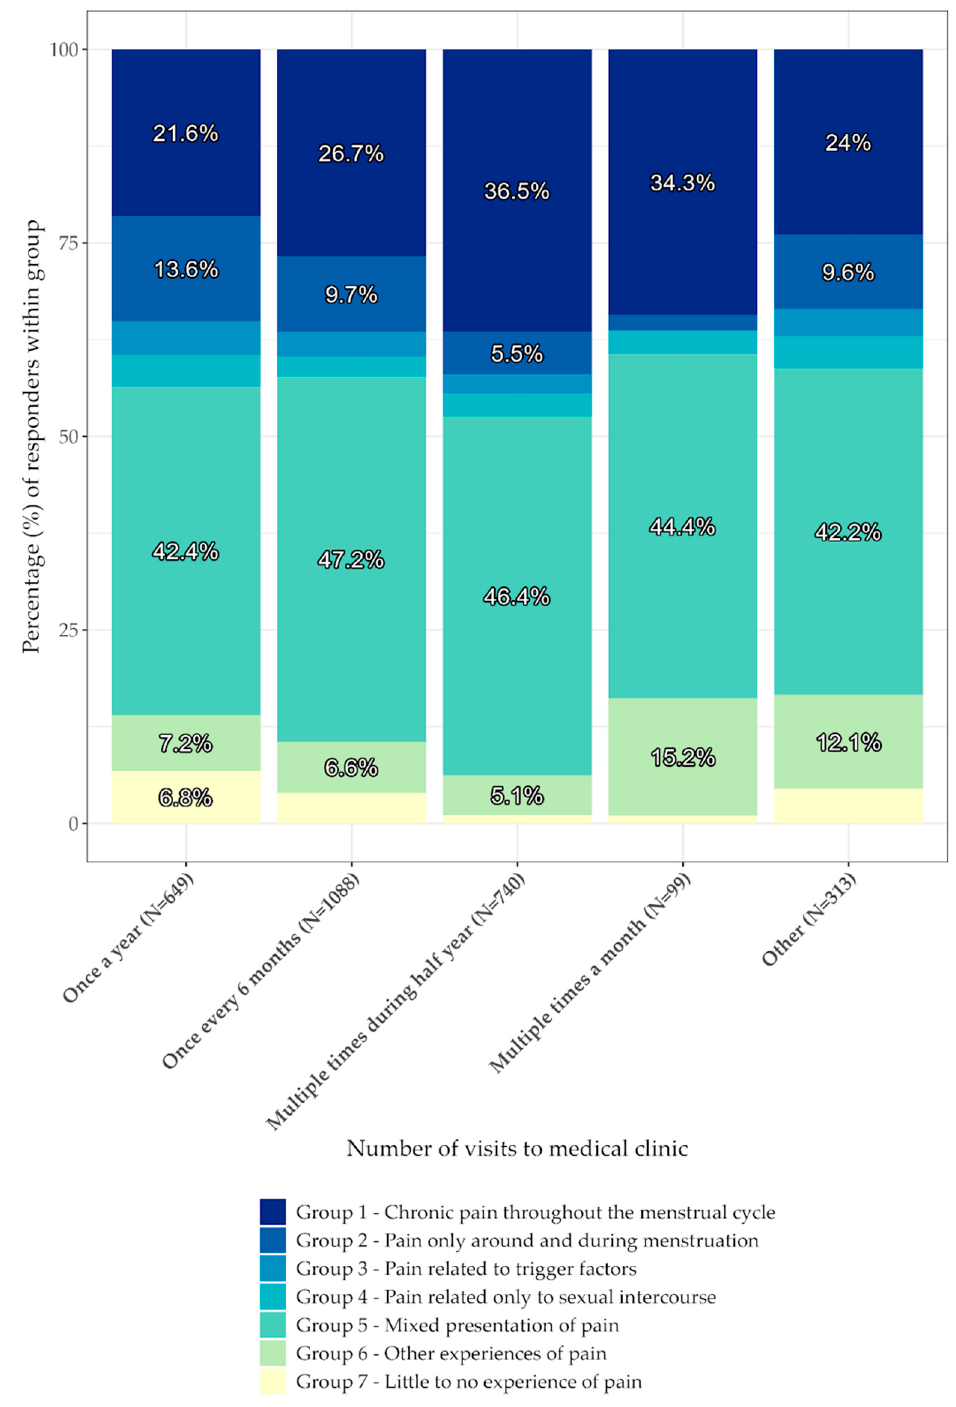
Figure 3. Reported pain in relation to medical appointments. The figure shows the percentage of participants within a defined group related to the frequency of their medical appointments. The percentages of respondents are shaded accordingly; group 1 is represented with the darkest shade (in blue), while group 7 is represented with the brightest shade (in yellow).